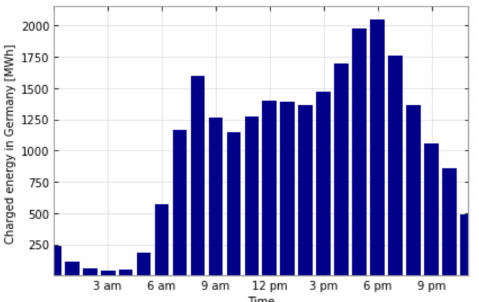
Figure 2. Charged energy of all i3 BEV for all of Germany in hourly